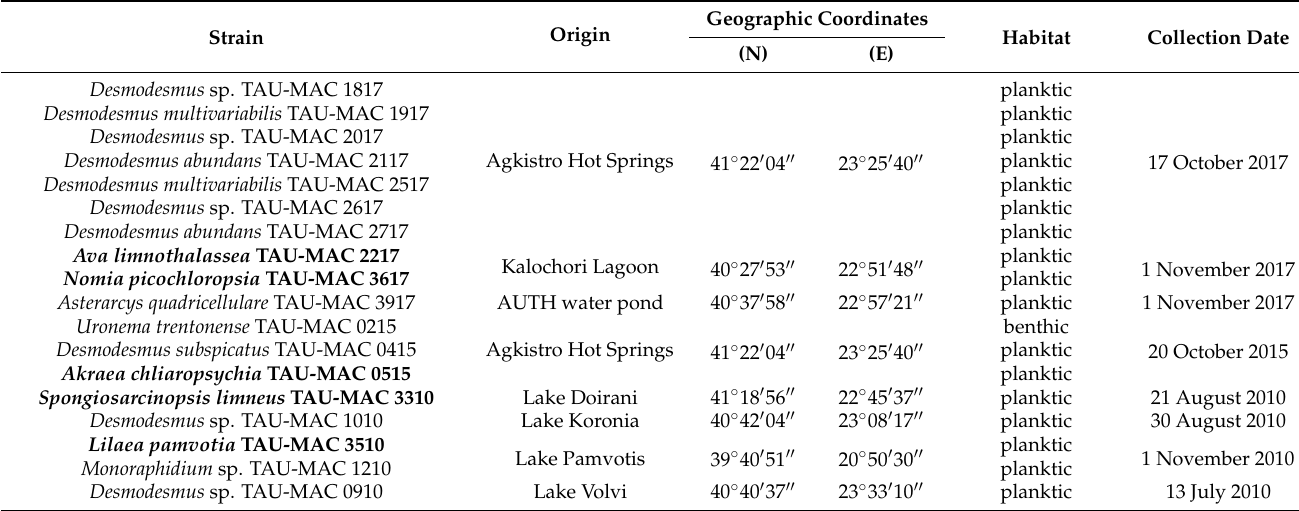
Table 1. Green algae strains investigated in this study, their origin, and habitat. Novel taxa described in this study are indicated in